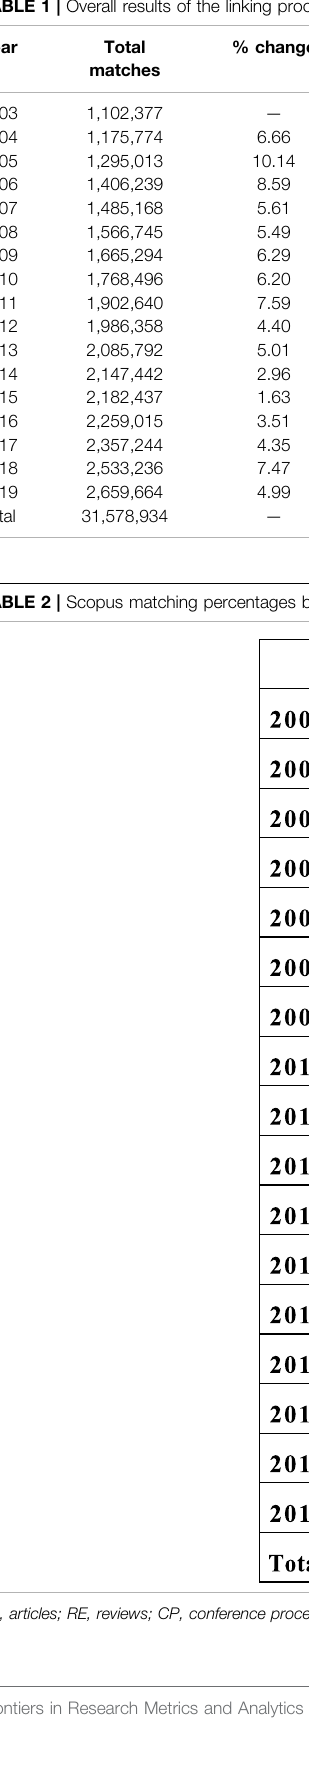
TABLE 1 | Overall results of the linking procedure.